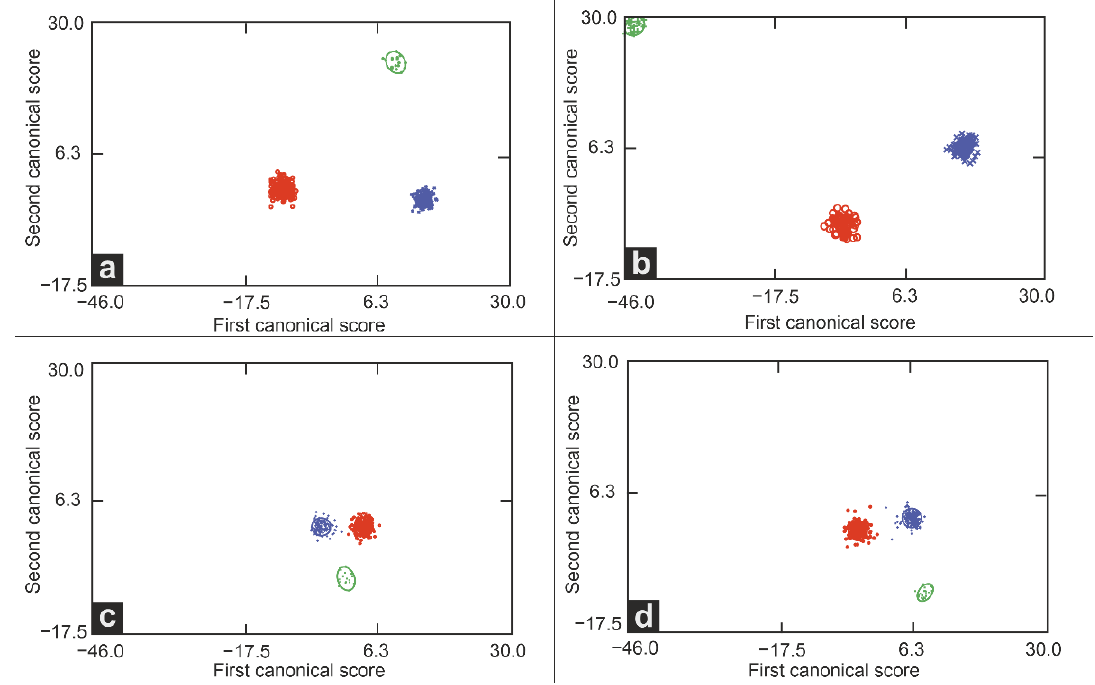
Figure 3. Comparison of canonical scores of MIR: ( a ) 1st derivative, ( b ) 2nd derivative, and NIR ( c ) 1st derivative, ( d ) 2nd derivative. Soil management: red — arable, blue — forest, green — grassland.